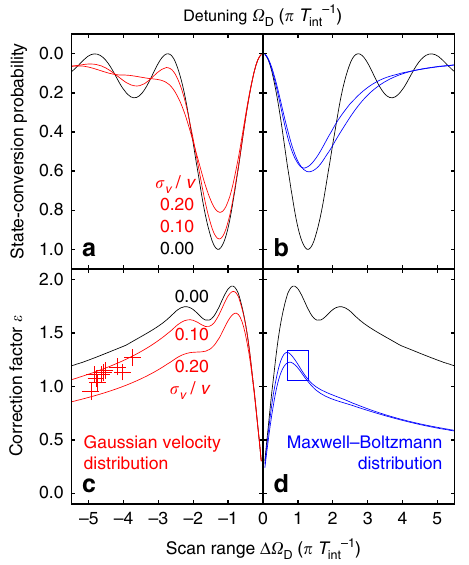
Figure 7 | Lineshape-dependent correction factors. The theoretical conversion probabilities F for a monoenergetic beam (black) is compared in ( a ) with the case of Gaussian distributed beam velocities of various widths (red) and in ( b ) with the Maxwell–Boltzmann distributed beam velocities (blue). The corresponding correction factors e as defined in equation (16) are shown in ( c , d ) for the compared velocity spreads, respectively. For ( a , b ) the x axis is the detuning O D , whereas for ( c , d ) it is . The crosses in ( c ) represent the the scan range D O D , both in units of p T (cid:3) 1 int correction factors for the ten sets. The correction factor for the estimate of required antihydrogen events is marked by a rectangle in ( d